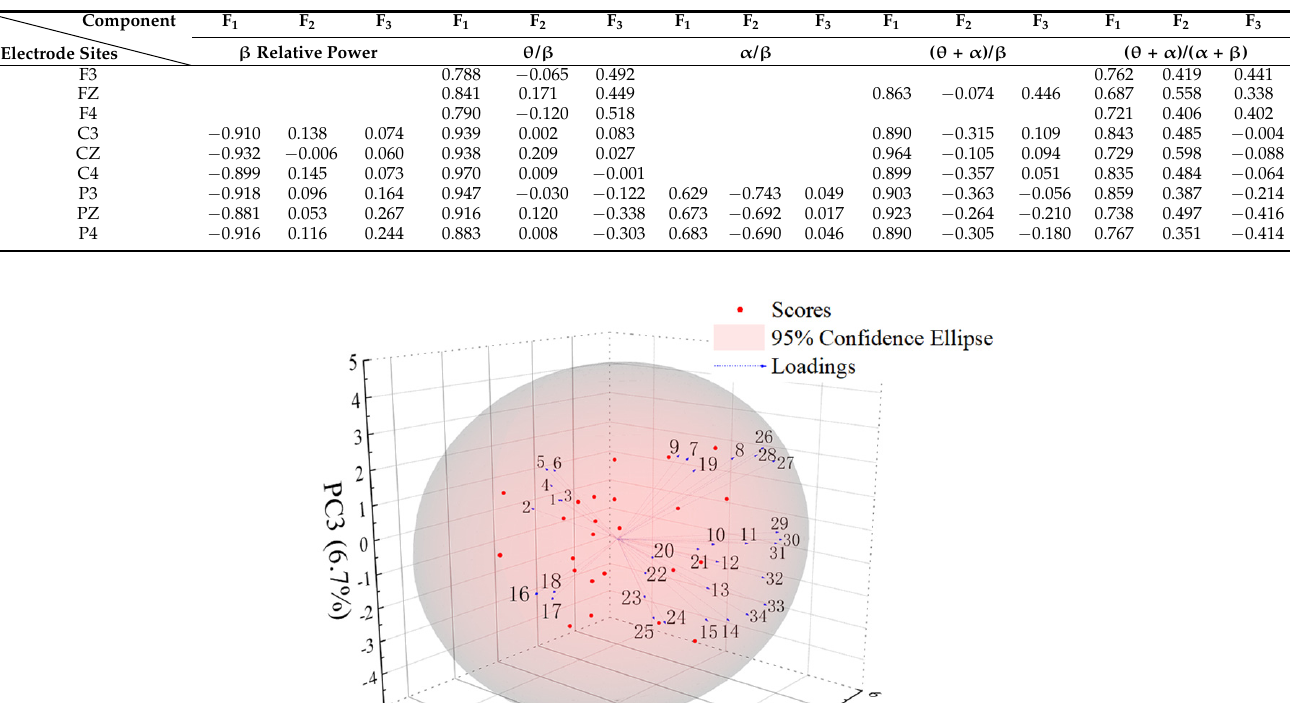
Table 4. Component matrix for SA-sensitive EEG features.